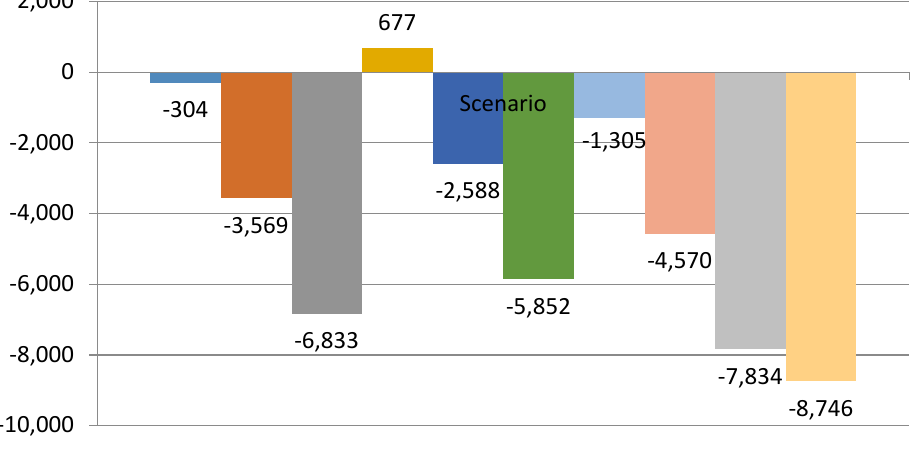
Figure 6. NPV for each scenario if the forecasting period equals seven years (tPLN).